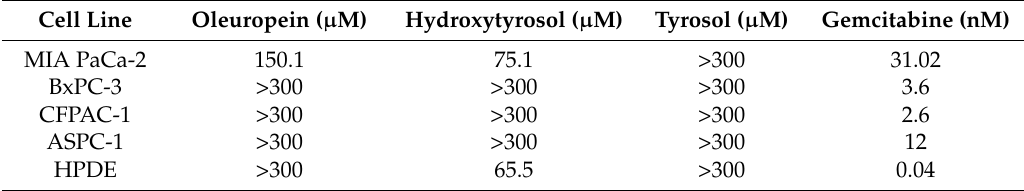
Table 1. Viability of pancreatic cancer cells (MIA PaCa-2, BxPC-3, CFPAC-1 and ASPC-1) and non-tumorigenic pancreas cells (HPDE) when treated with 0–300 µ M of oleuropein, hydroxytyrosol or tyrosol. Values represent concentration required to achieve a 50% reduction in viability (IC 50 ). Cell Line Oleuropein ( µ M) Hydroxytyrosol ( µ M) Tyrosol ( µ M) Gemcitabine